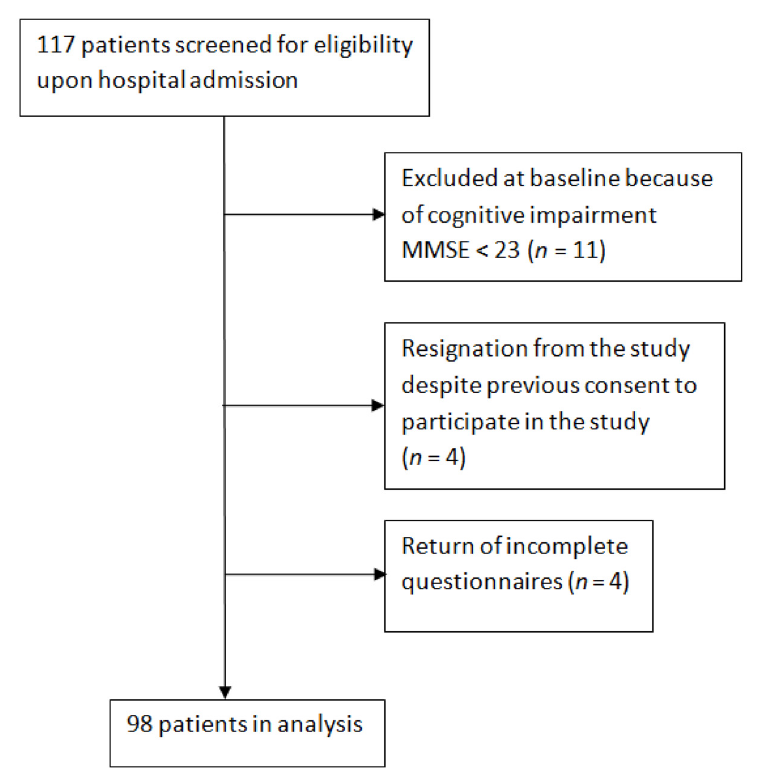
Figure 1. Flowchart of the study population.